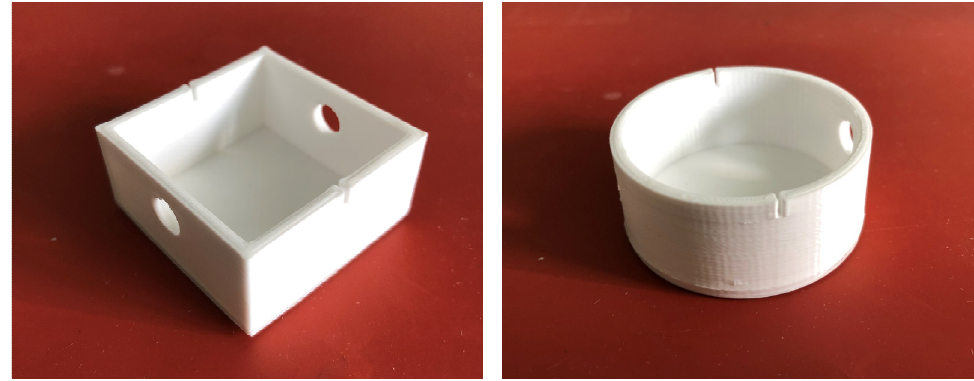
Figure 5. Resulting specimens with conventional production, geometries “EG” and “RG” (taken after the tensile test).